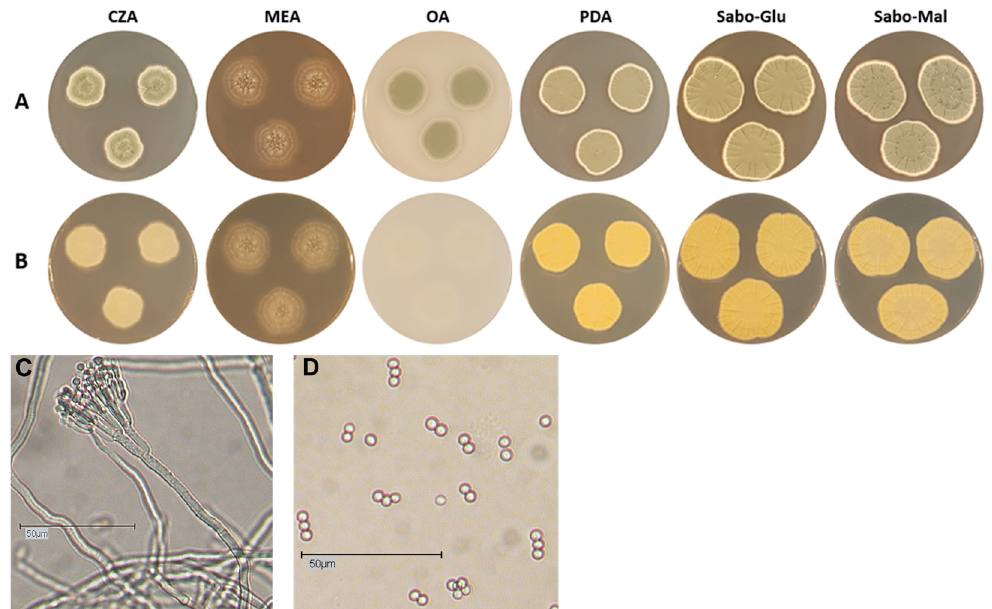
Figure A1. Macroscopic and microscopic characteristics of Penicillium crustosum . Growth was stud- ied on different culture media (Appendix A). A 20 µL spore suspension (5 × 10 5 spores per mL) was pipetted three times onto different solid media and incubated at 21 °C for five days. ( A ) Surface growth and ( B ) colony reverse were documented photographically. Using transmitted light micros- copy (light microscope DMRBE, Leica, Wetzlar, Germany), hyphal growth, ( C ) conidiophore struc- ture and ( D ) spores of Penicillium crustosum were examined.